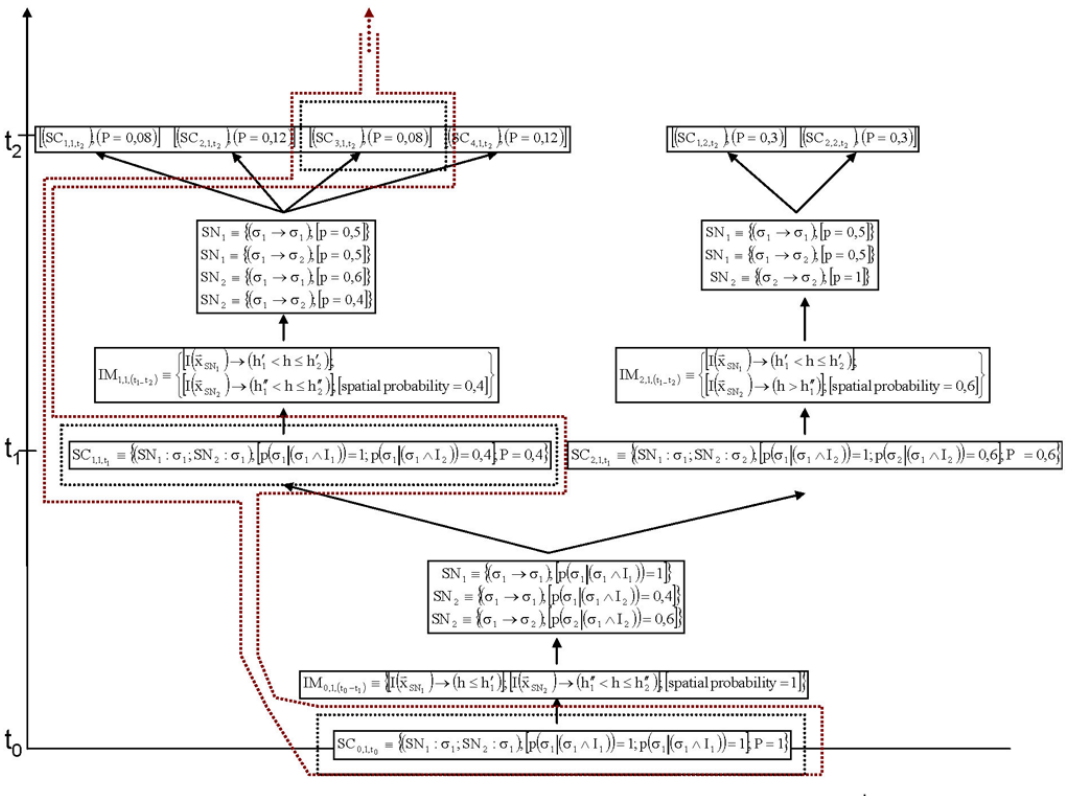
(cid:12) (cid:12) I q . Only two time steps are considered. SC stands for system (cid:12) j ,j